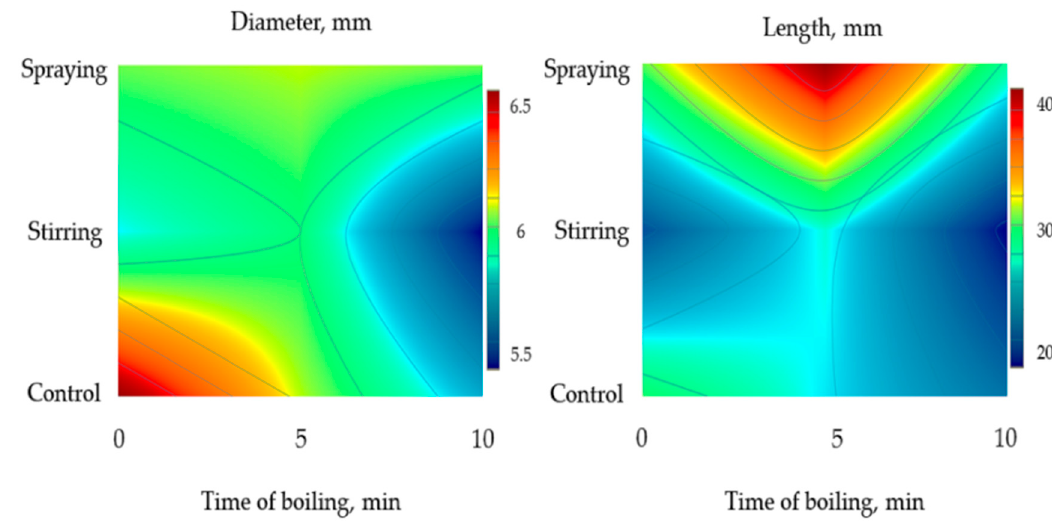
Figure 2. Two-dimensional fuzzy contour plotting for the interactive effect of time of boiling and method of addition on the diameter and length of non-wood pellets from pressing residual biomass from distillation of cellulosic bioethanol with liquid-state food waste.